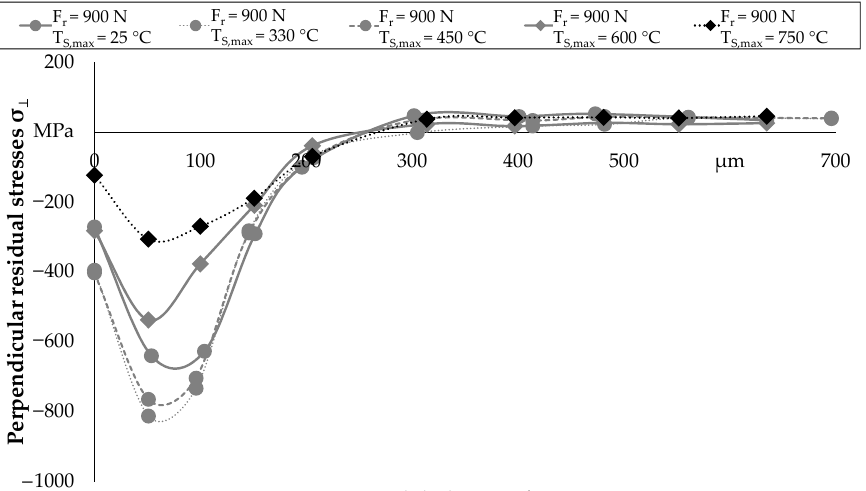
Figure 6. residual stress depth distribution perpendicular to the rolling direction for T S,max = 25 °C, 330 °C, 450 °C, 600 °C and 750 °C with the deep rolling force F r = 900 N.